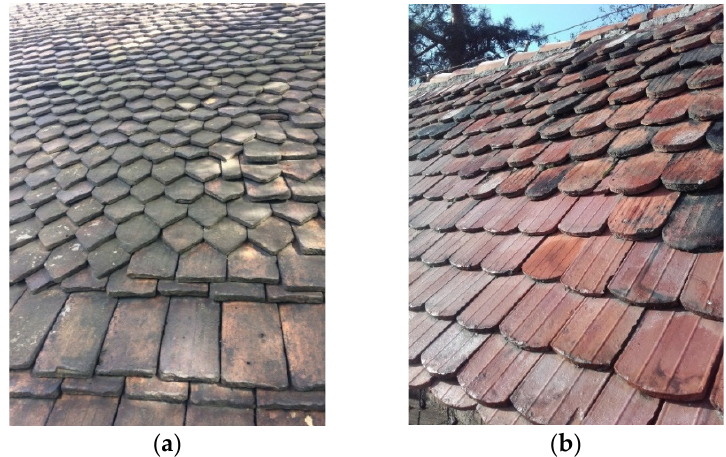
Figure 2. Examples of historic roof coverings after many years of use: ( a ) handmade late medieval and Renaissance roofing tile; ( b ) machine-made tiles approximately 100 years old.